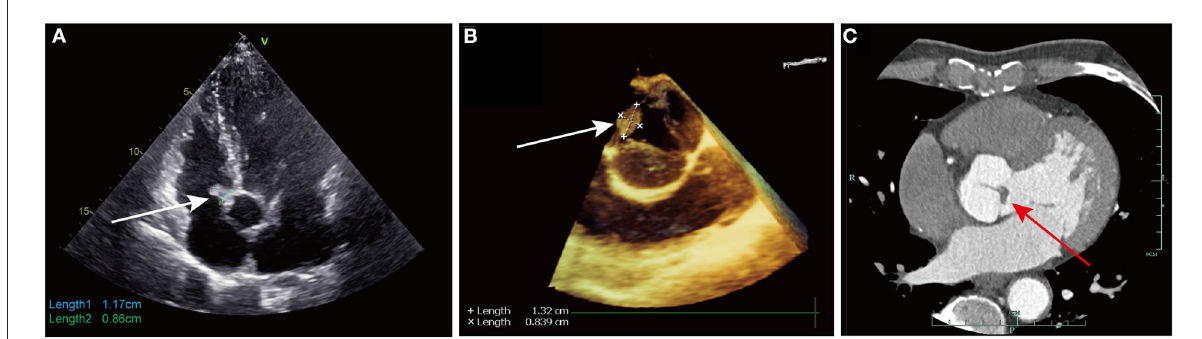
FIGURE1 (A) Transthoracic echocardiography showed an irregular hyperechoic mobile mass (1.2 × 0.9cm in size, white arrow) with a stalk arising from the right atrium adjacent to the aortic root; (B) Transesophageal echocardiography showed an additional mobile mass (1.3 × 0.8cm in size, white arrow) on the ventricular side of the non-coronary cusp of aortic valve; (C) Coronary computed tomography angiography showed abnormal thickness of non-coronary cusp of aortic valve, which represented the cardiac papillary fibroelastoma (red arrow) on the aortic valve.